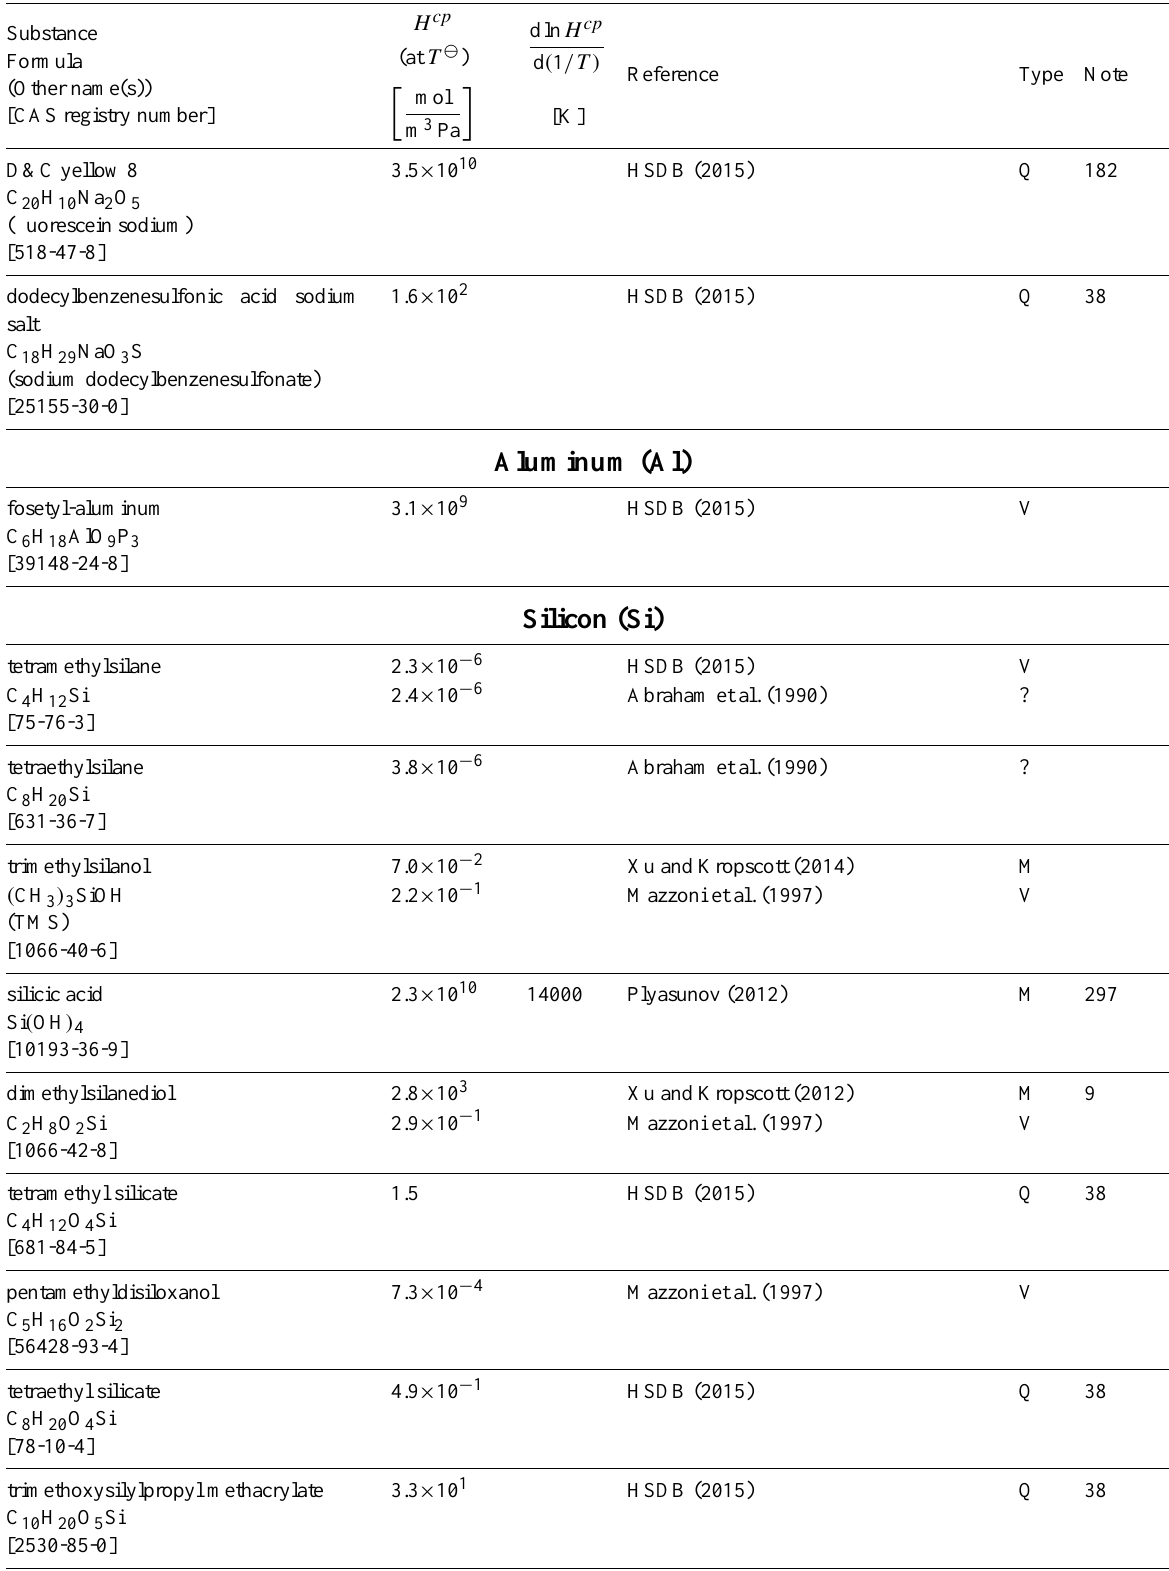
Table 6: Henry’s law constants for water as solvent